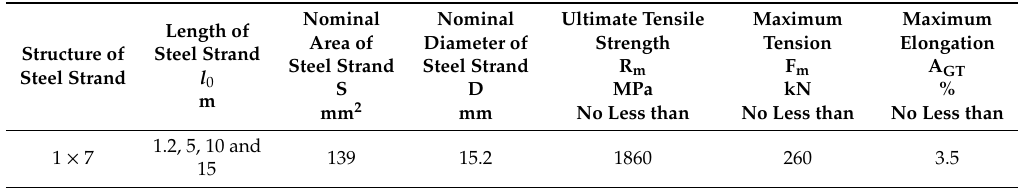
Table 1. Parameters of steel